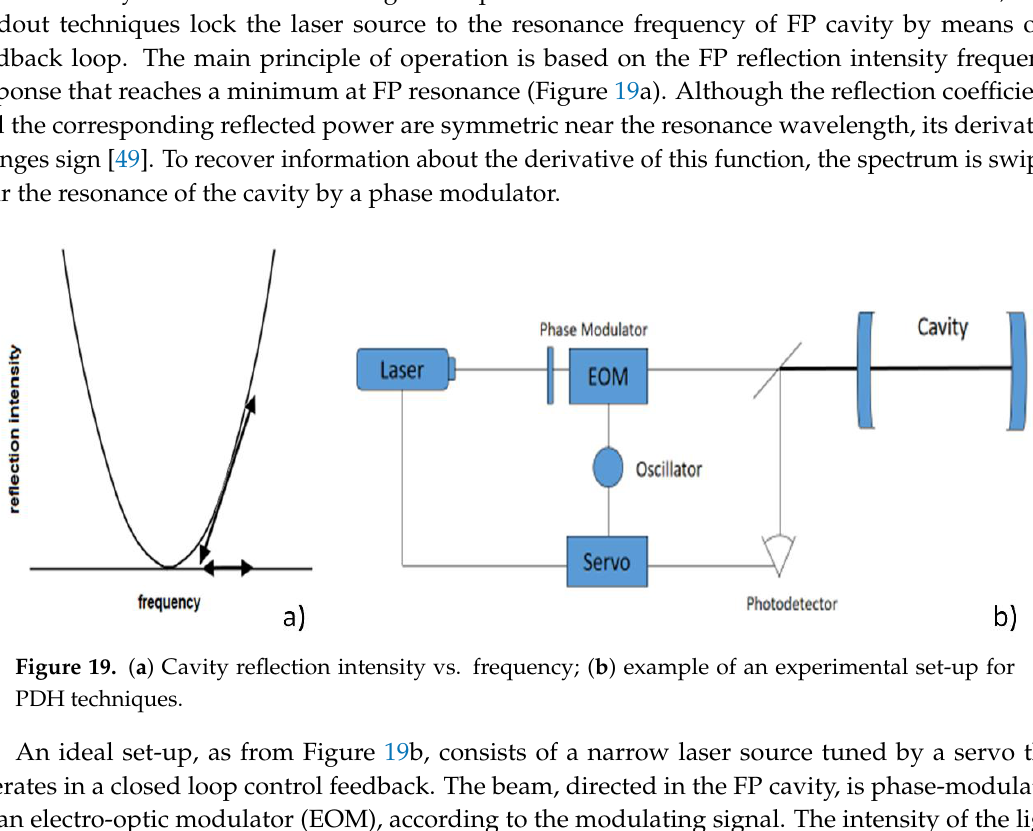
16 of 27 Figure 18. Example of an experimental set-up for interferometric interrogation technique.